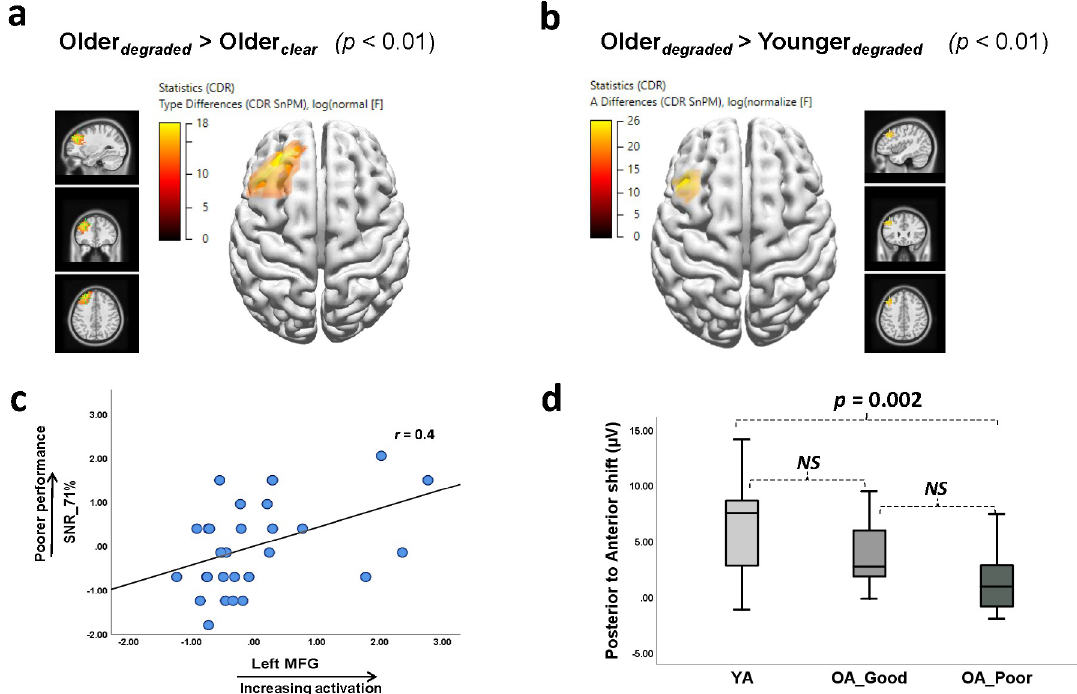
Fig 7. Top panel: a , b . Displays results of the current density reconstruction statistical nonparametric mapping (CDR SnPM) testing. The input data for the CDR SnPM were the standardized Low Resolution Brain Electromagnetic Tomography (sLORETA) source images for the conditions compared. Source analyses revealed that Older participants recruited the left prefrontal cortex during degraded listening. Bottom panel: c . Scatter plot describing a significant positive correlation between scores on the digits-in-noise recognition task (SNR 71% ) and the left middle-frontal-gyrus activation in the Older participants ( r = 0.42, p = 0.01). d . Displays differences in P3 amplitudes (Pz minus Fz electrodes) across younger ( n = 20), good ( n = 15) and poor ( n = 15) older participants.